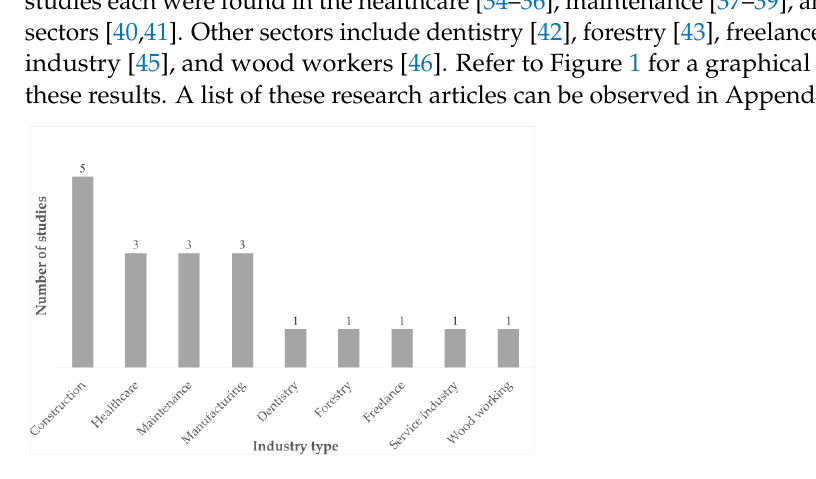
Figure 1. Number of safety climate studies in Indonesia by industry.